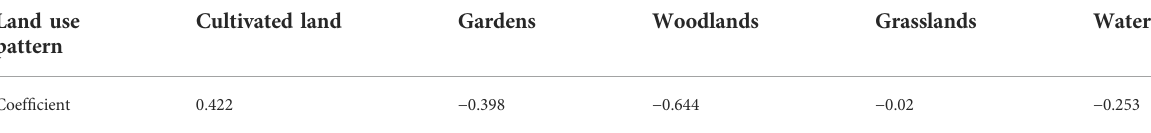
TABLE 2 Carbon emission coef fi cient of different types of land use (t/hm 2 · y).